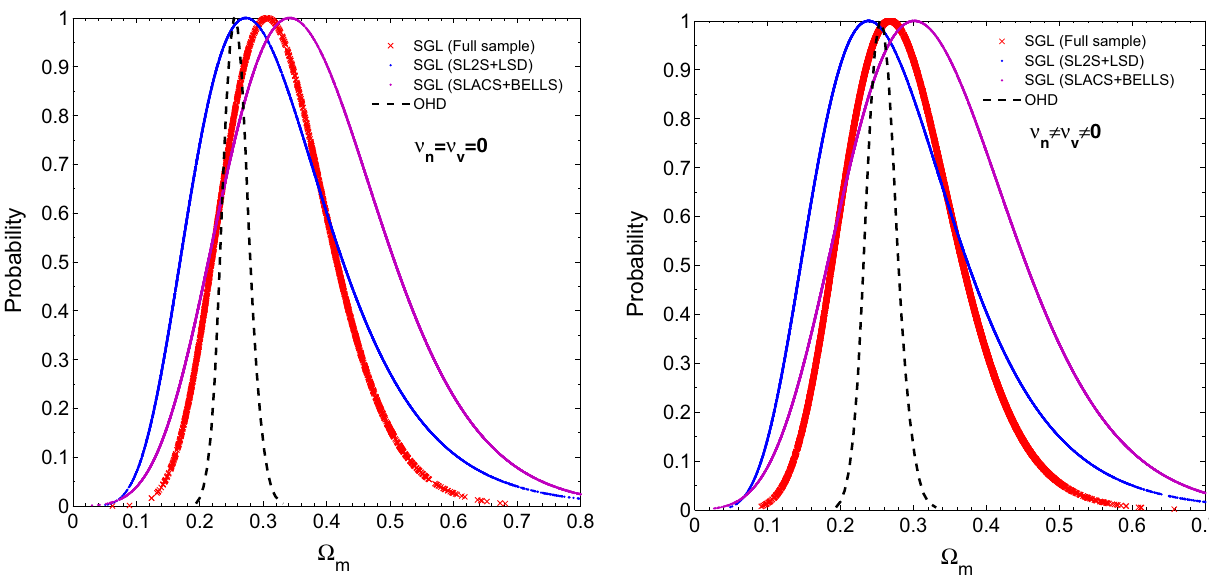
Fitting results from recent observational Hubble parameter data (OHD) are also added for comparison